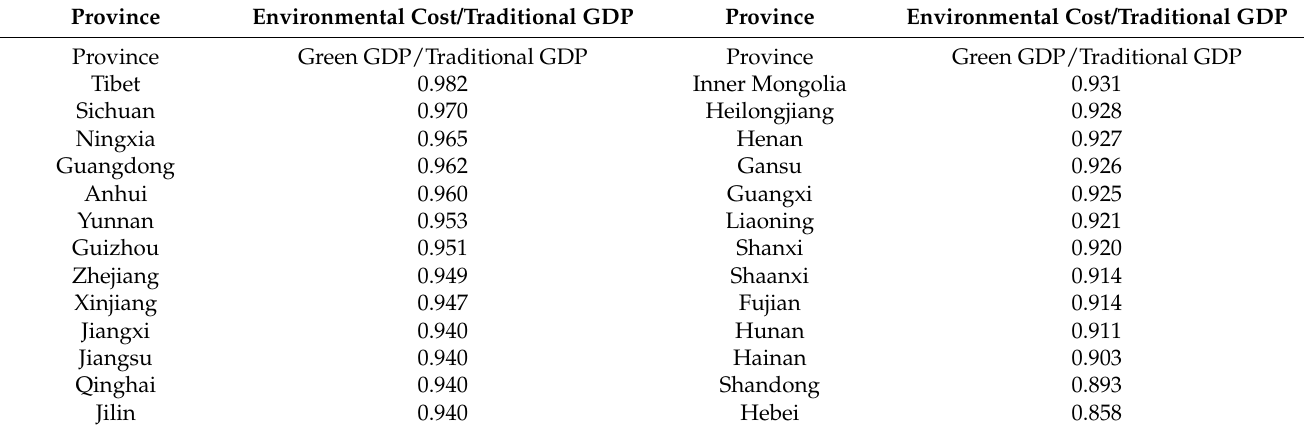
Table 8. Rate of agricultural green GDP to traditional GDP for 27 provinces in